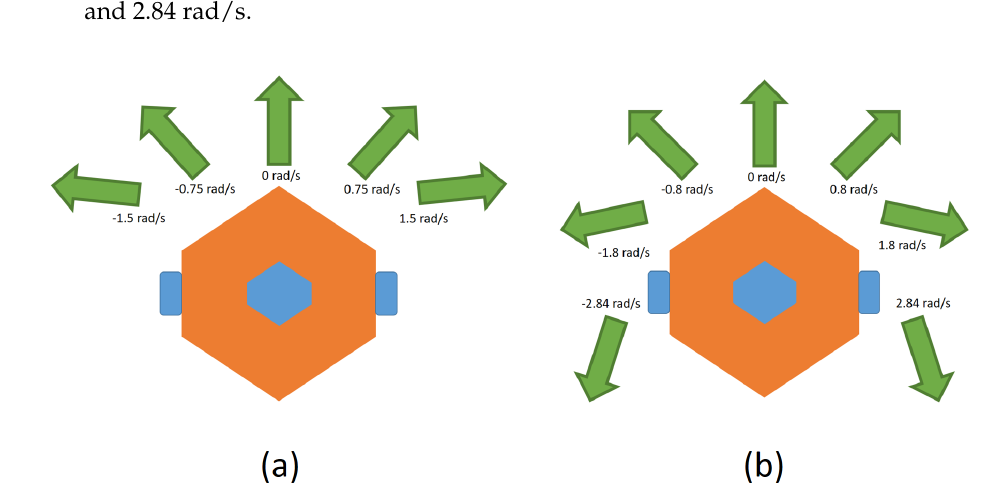
Figure 2. Two kinds of rotation modes for DQN: ( a ) 5 states and ( b ) 7